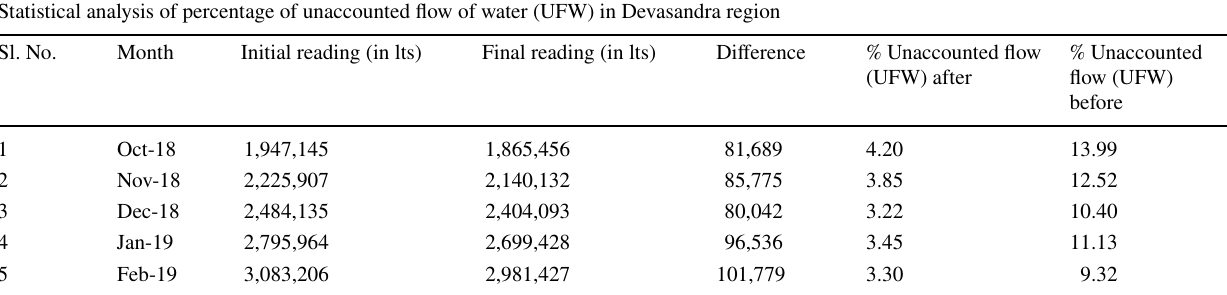
Table 3 Percentage of water losses before and after implementation of methods Statistical analysis of percentage of unaccounted flow of water (UFW) in Devasandra region Sl.